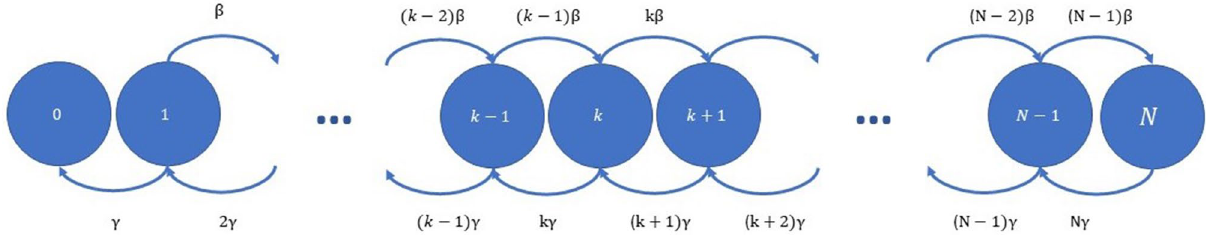
Figure 5. Continuous Time Markov Chain for Cluster-5 infected.